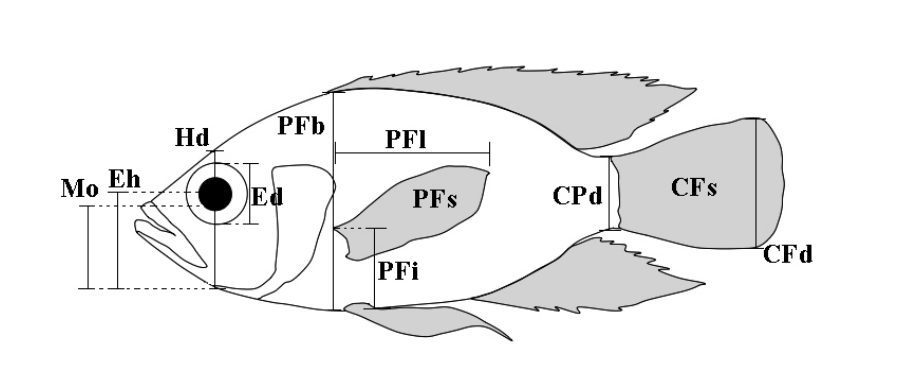
FIGURE 2 | Morphometric measures taken from digital pictures: CPd – caudal-peduncle minimal depth, CFd – caudal-fin maximum depth, CFs – caudal-fin surface, PFi – distance from pectoral-fin insertion to the bottom of the body, PFb – body depth at the level of the pectoral-fin insertion, PFl – pectoral-fin length, PFs – pectoral-fin surface, Hd – head depth along the vertical axis of the eye, Ed – eye diameter, Eh – distance from the center of the eye to the bottom of the head, Mo – distance from the tip of the upper jaw to the bottom of the head along the head depth axis. Adapted from Leitão et al .